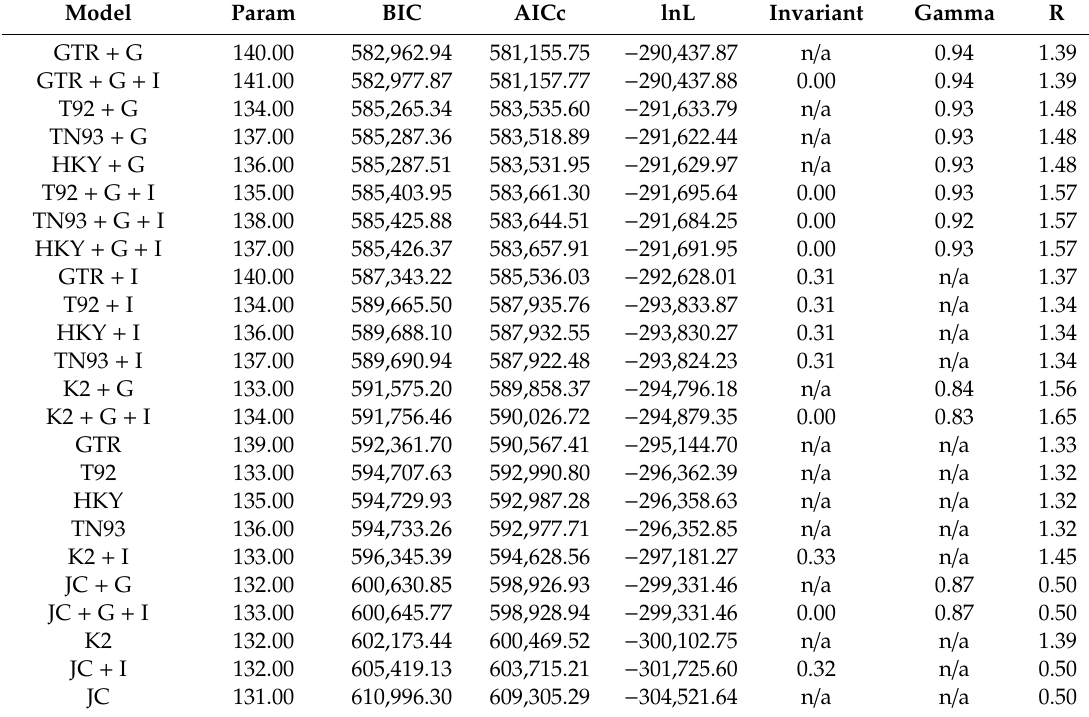
Table A3. Best model selection based on the Maximum Likelihood method.